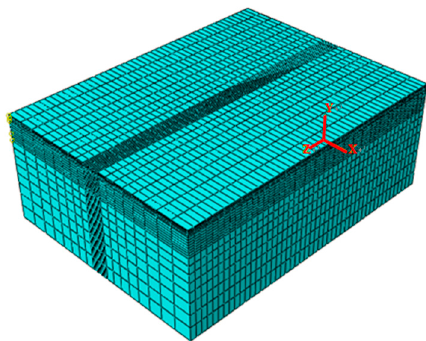
Figure 1. Finite element model of pavement structure.